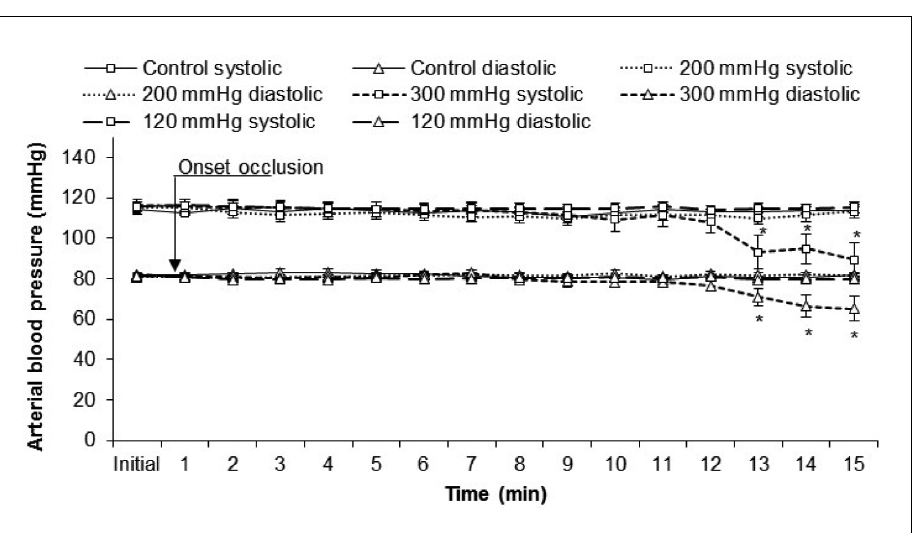
( p < .05) . In the control group after rest without occlusion, arterial blood flow intensity increased only 17 ± 9.9% ( p > .05). After 3 min recovery, blood flow intensity returned to the baseline level (Figure 3). Applied 300 mmHg occlusion ( p < .05, ŋ 2 = 0.695, OP = 0.1) immediately after occlusion removal, diastolic and systolic arterial blood pressure was decreased statistically significantly till 4 min of recovery ( p < .05), compared to initial values before occlusion. In the other experimental groups with 120, 200 mmHg occlusion pressure, it had no significant effect on systolic and diastolic blood pressure ( p > .05), there was also no change in the control group (Figure 4).